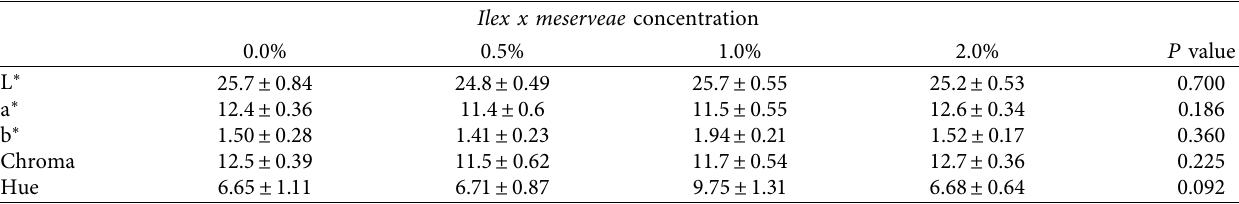
Table 2: Effect of Ilex meserveae on color parameters of dry-aged beef.